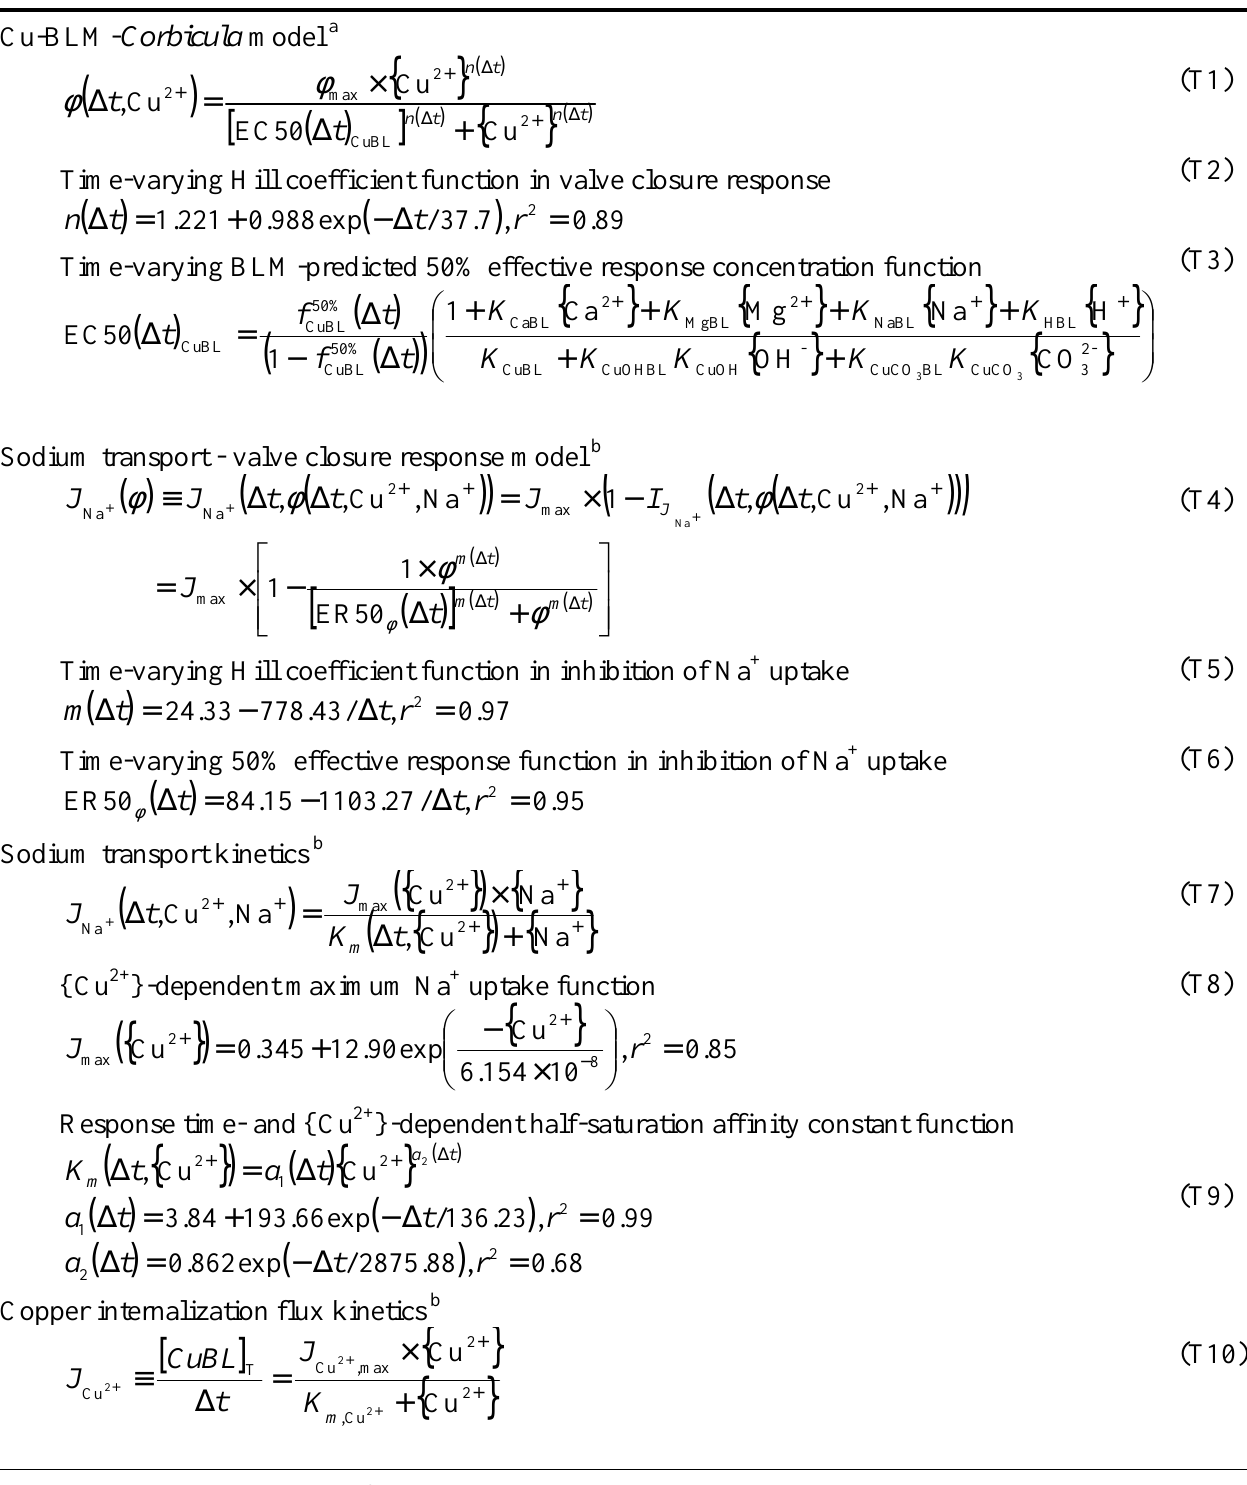
Table 3 The mathematical descriptions for Cu-BLM-Corbicula model associated with Na transport mechanism and valve closure response in C. fluminea in response to waterborne Cu (see text for the meanings of